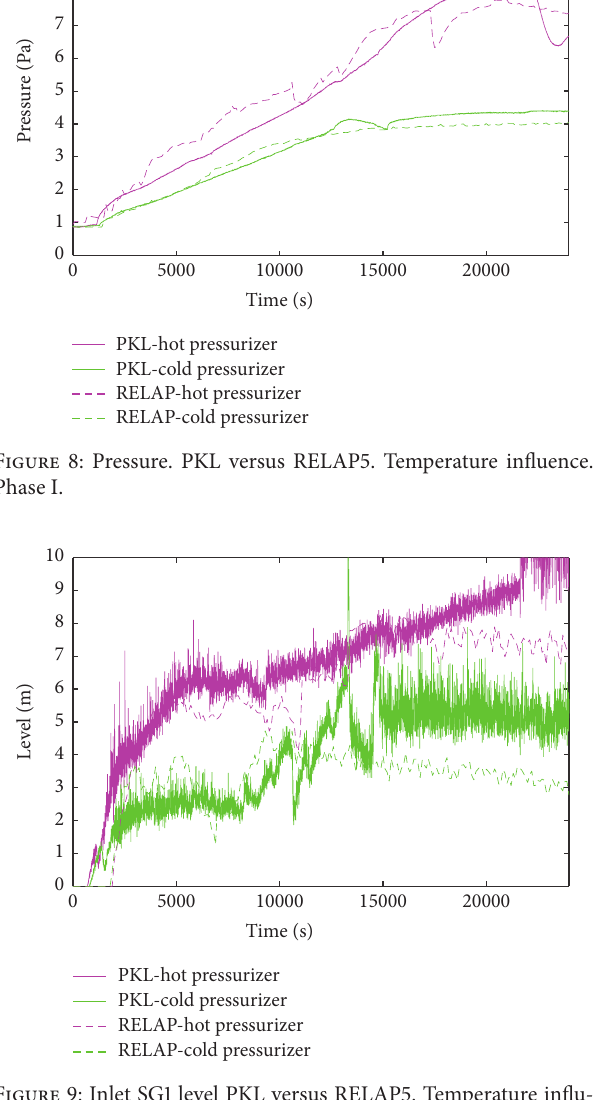
Figure 9: Inlet SG1 level PKL versus RELAP5. Temperature influ- ence. Phase I.